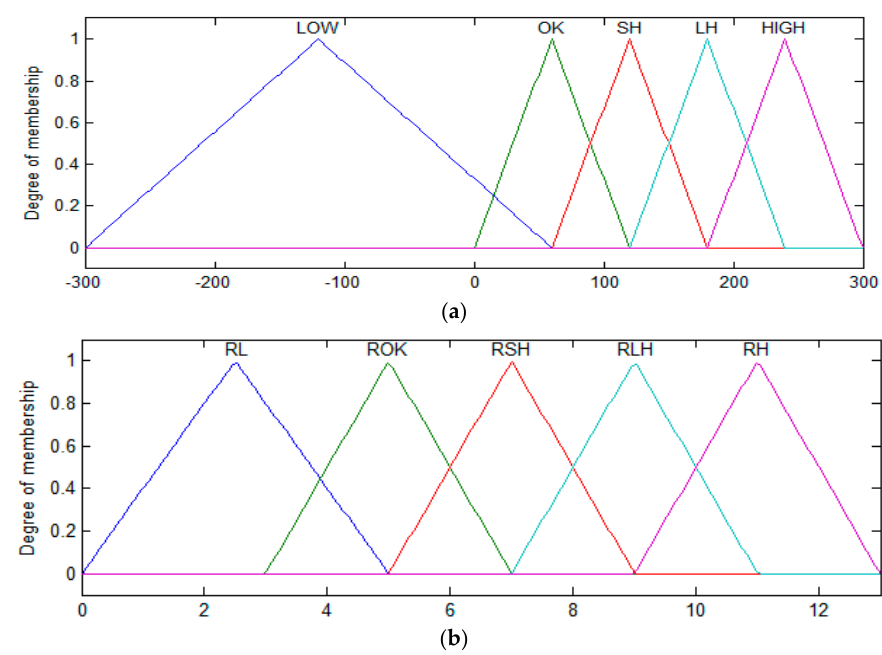
Figure 17. Membership functions for air quality. ( a ) Input e A , ( b ) output RPV.